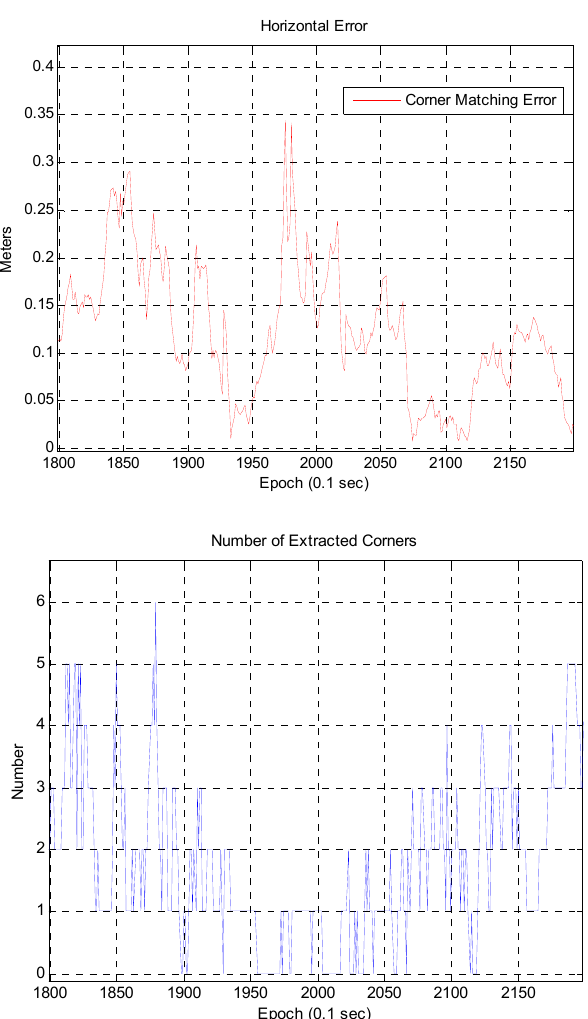
Figure 22. Relationship between the localization error and the number of extracted corners.